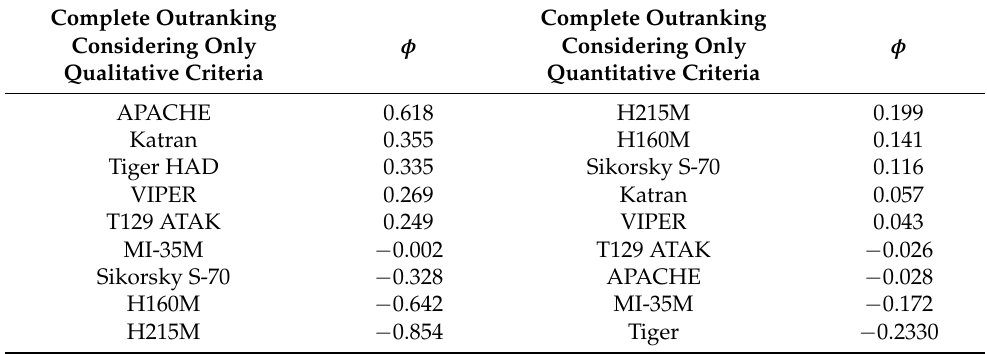
Table 19. Complete ranking in scenarios considering only quantitative or qualitative